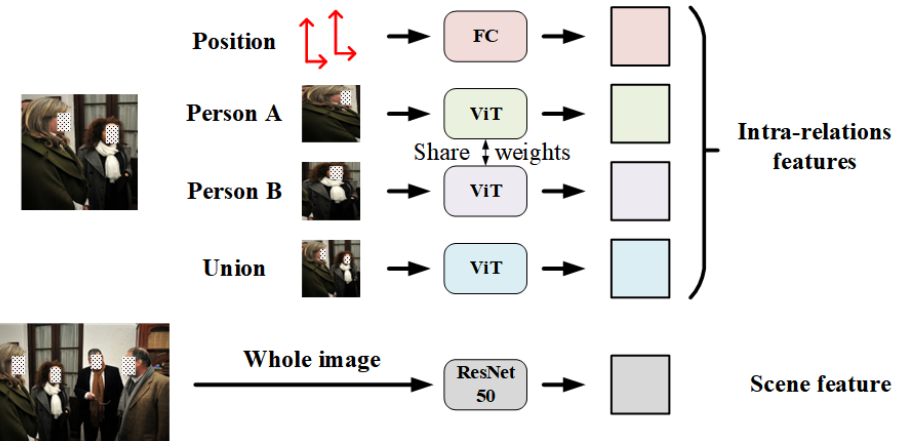
Figure 3. Illustration of feature extraction. Note that here we only take one person pair in the input image as an